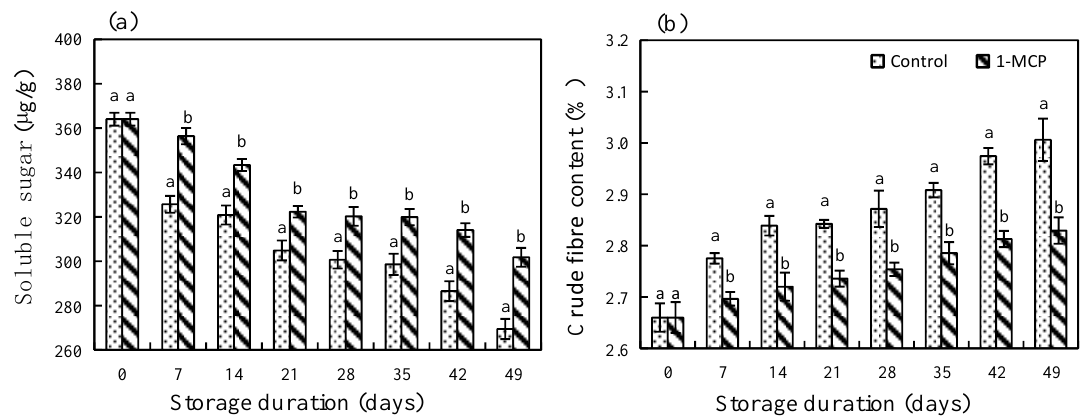
Figure 4. Effects of 1 − MCP treatment on soluble sugar and crude fibre of “Dianhong” rose petals in different storage periods: ( a ) Effect of 1 − MCP on soluble sugar content; ( b ) Effect of 1 − MCP on crude fibre content. Different letters on the bar chart indicate significant differences among group ( p < 0.05, n = 3).